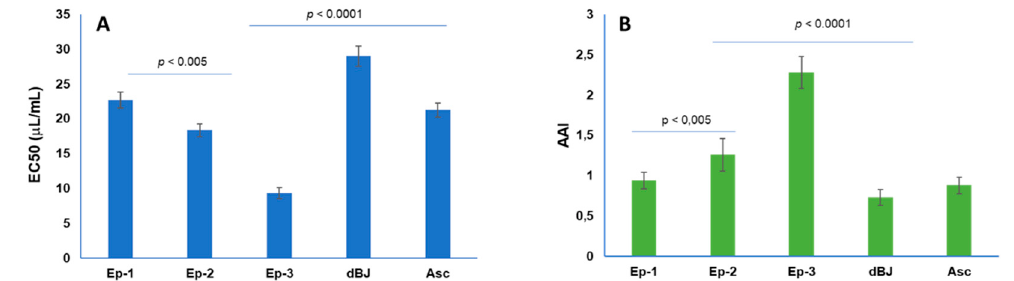
Figure 3. Antioxidant activity expressed as EC 50 ( A ) and antioxidant activity index (AAI) ( B ) of bergamot juice obtained using 3 different juice extraction methods: hand squeezing (Ep-1); FMC (Ep-2); screw press of peeled fruits (Ep-3); and in debittered bergamot juice (dBJ). Asc: ascorbic acid (positive control). Error bar represent standard deviation ( n = 3).